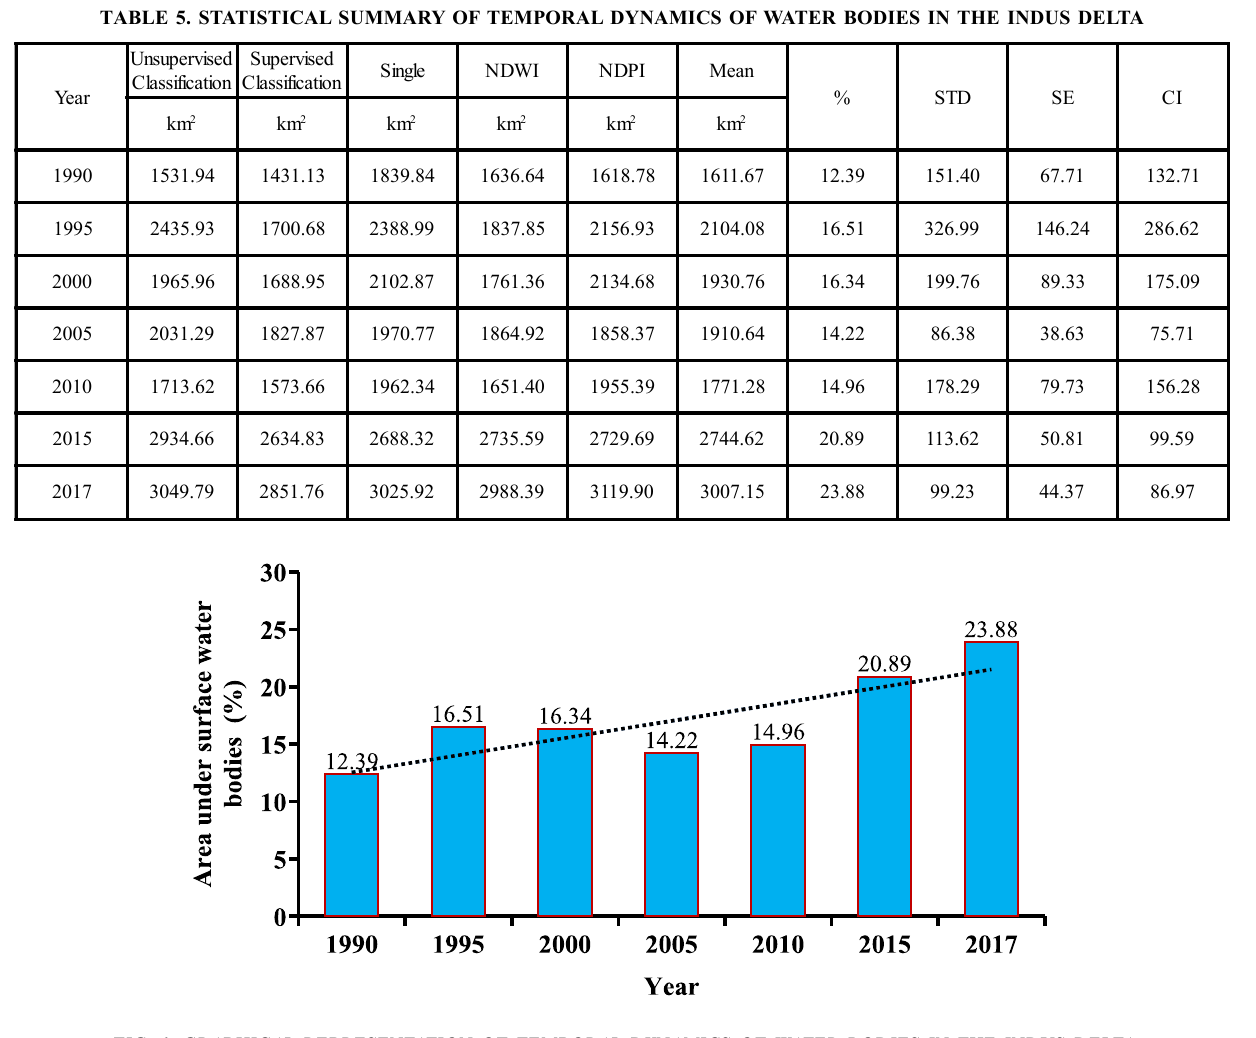
FIG. 6. GRAPHICAL REPRESENTATION OF TEMPORAL DYNAMICS OF WATER BODIES IN THE INDUS